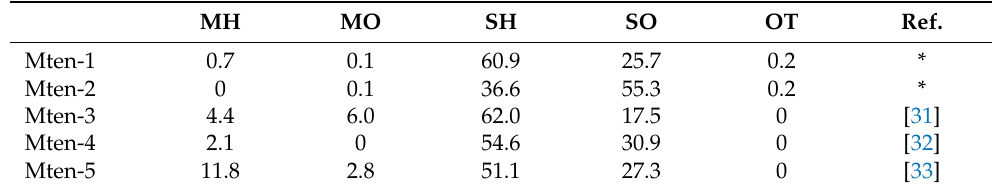
Table A2. Compound classes and volatile concentrations used in the multivariate statistical